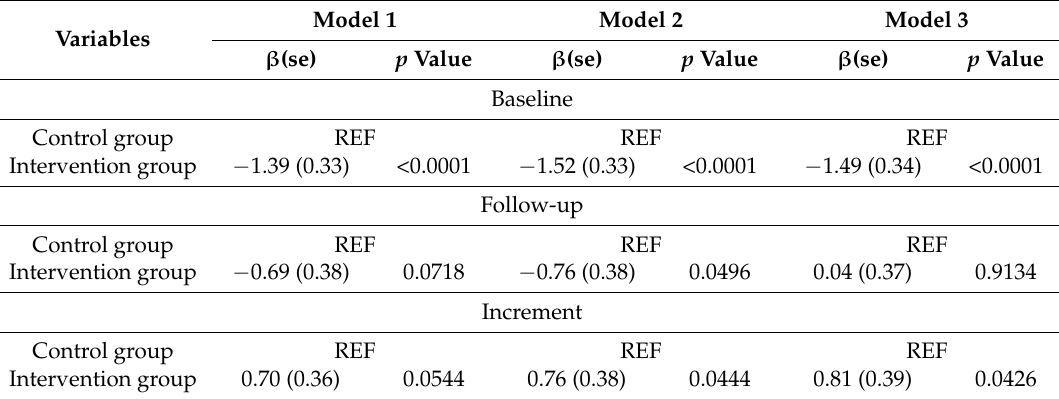
Table 5. Adjusted association of vitamin D intervention with 25(OH)D concentrations among school children ( N =